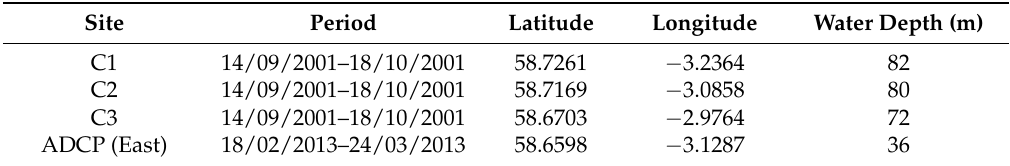
Table 2. Details of the velocity acoustic Doppler current profiler (ADCP) data used for the model